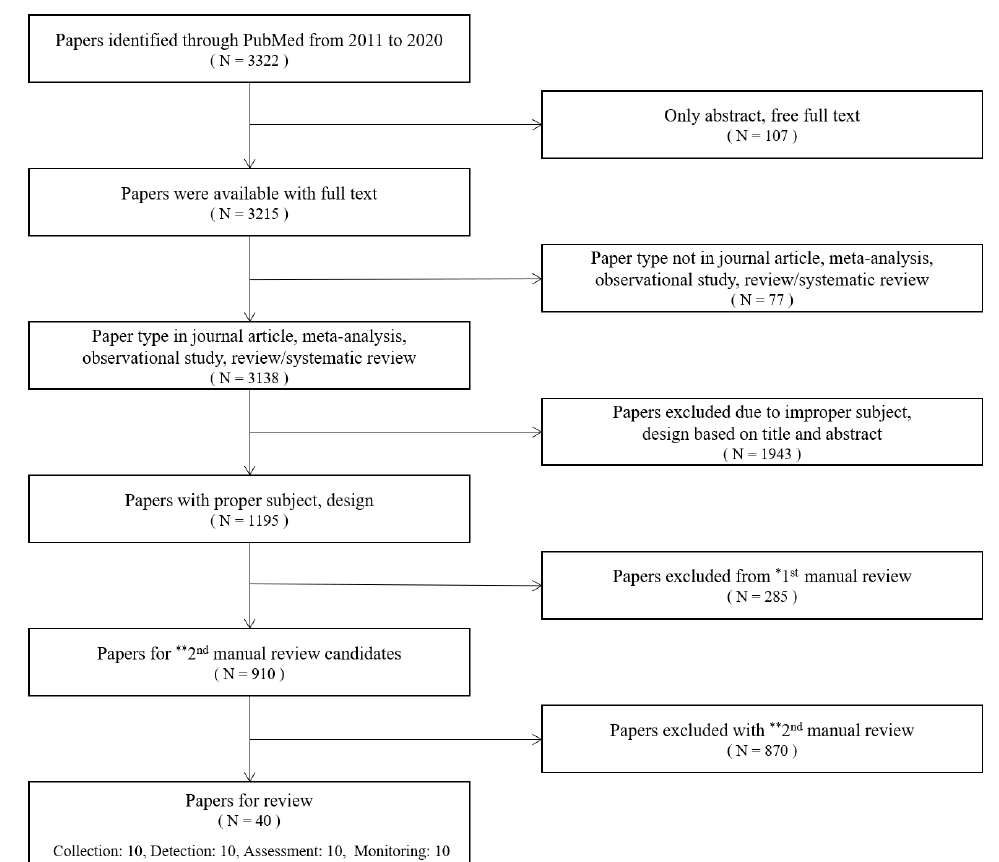
Figure 1. Flowchart depicting the paper selection process. * 1st manual review: animal experiment, not drug-induced, clinical effect; ** 2nd manual review: diversity and authenticity of databases, methods.